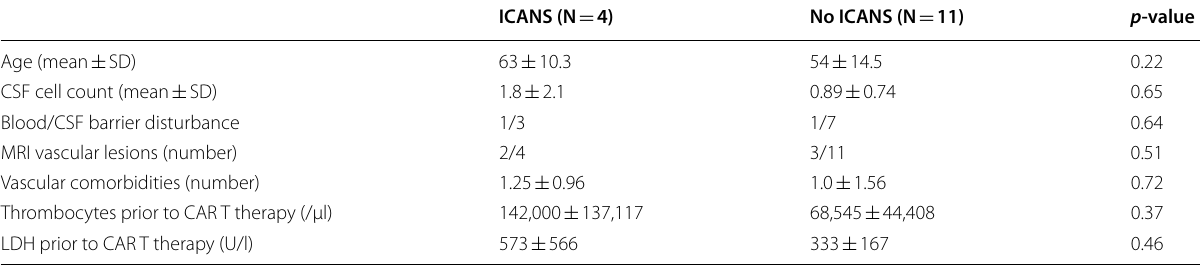
Data presented as means SD. CRS: cytokine release syndrome; CSF: cerebrospinal fluid; ICANS: immune effector cell associated neurotoxicity syndrome; LDH: lactate ± dehydrogenase; MRI: magnetic resonance imaging; Student’s two-tailed t test was used to calculate the p